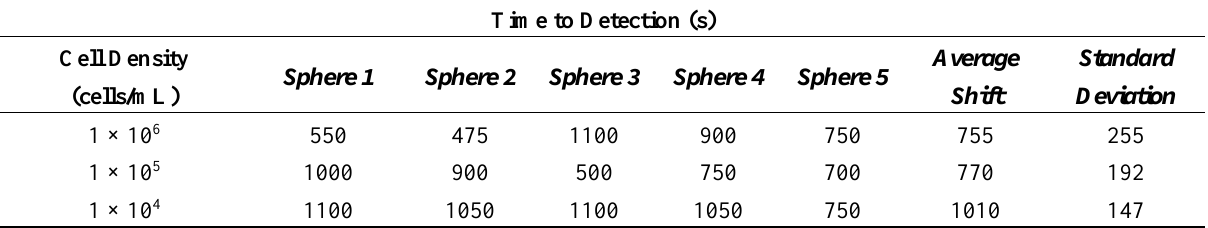
Table 2. Time to detection for each cell density tested, as defined by the amount of time required for the wavelength shift to